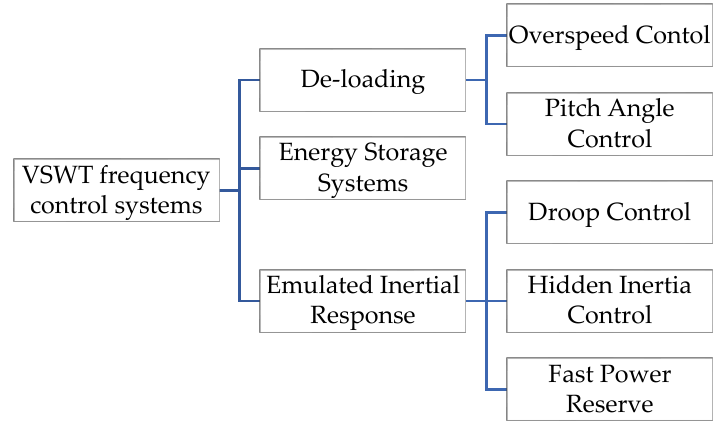
Figure 2. General Classification of VSWTs Frequency Control Systems [16].